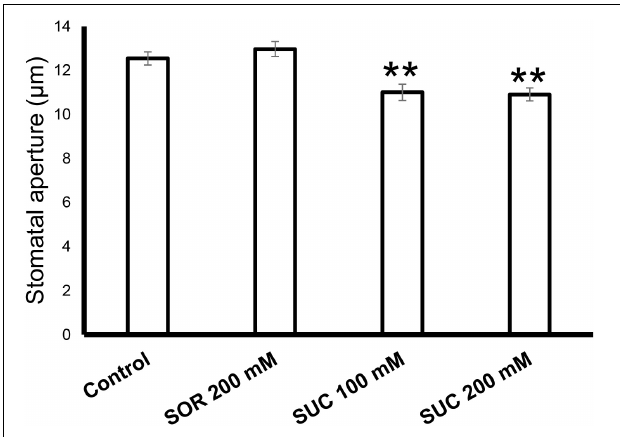
FIGURE 4 | Sugar stimulates the closure of citrus fruit stomata. The stomatal response to sucrose in WT fruit rind was assayed with rind discs (taken from six fruits) that were immersed for 2.5 h in artificial xylem sap (Wilkinson and Davies, 1997), artificial xylem sap containing 200 mM sorbitol (as an osmotic control), 100 mM sucrose (Suc), and 200 mM Suc. Epidermal imprints were then taken and the apertures of 60 stomata from each treatment were measured. Data are displayed as means ± SE. Asterisks denote significant differences relative to the WT ( t -test, P < 0.01).